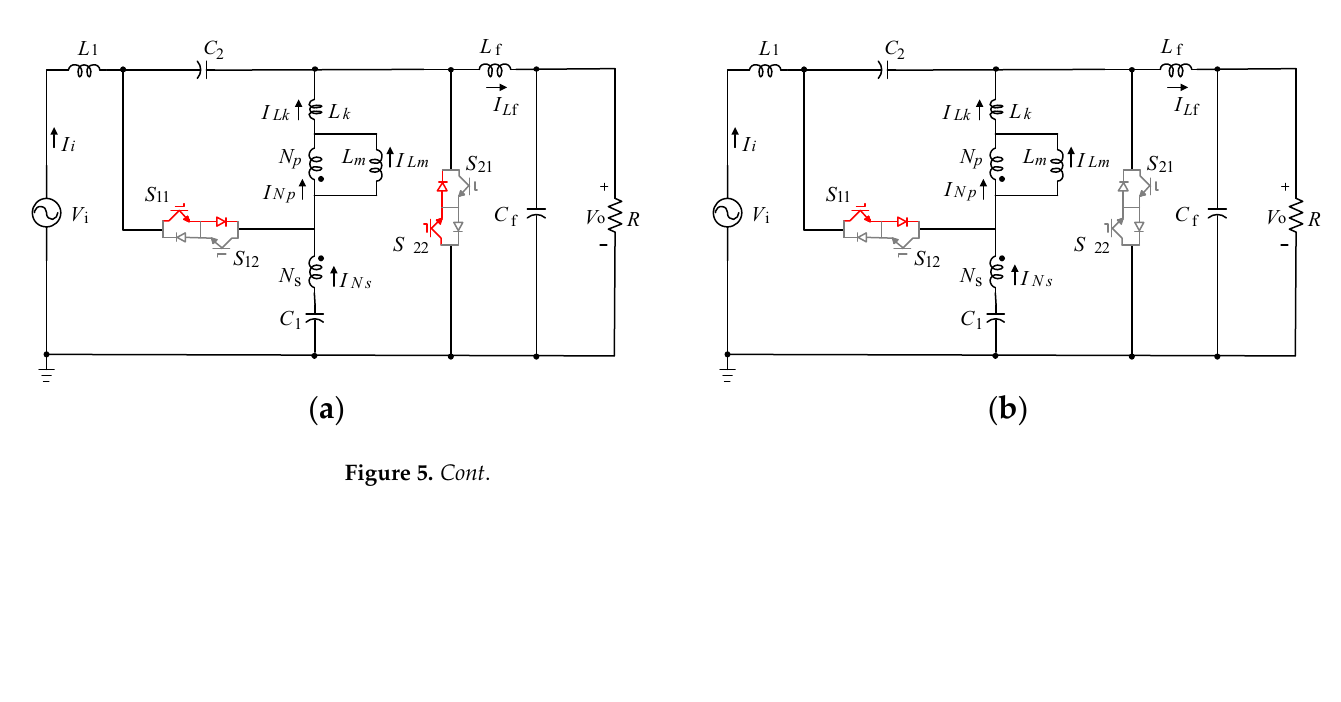
Figure 4. Switching signals of safe commutation approach in ( a ) boost in-phase mode and ( b ) buck/boost out-of-phase mode.